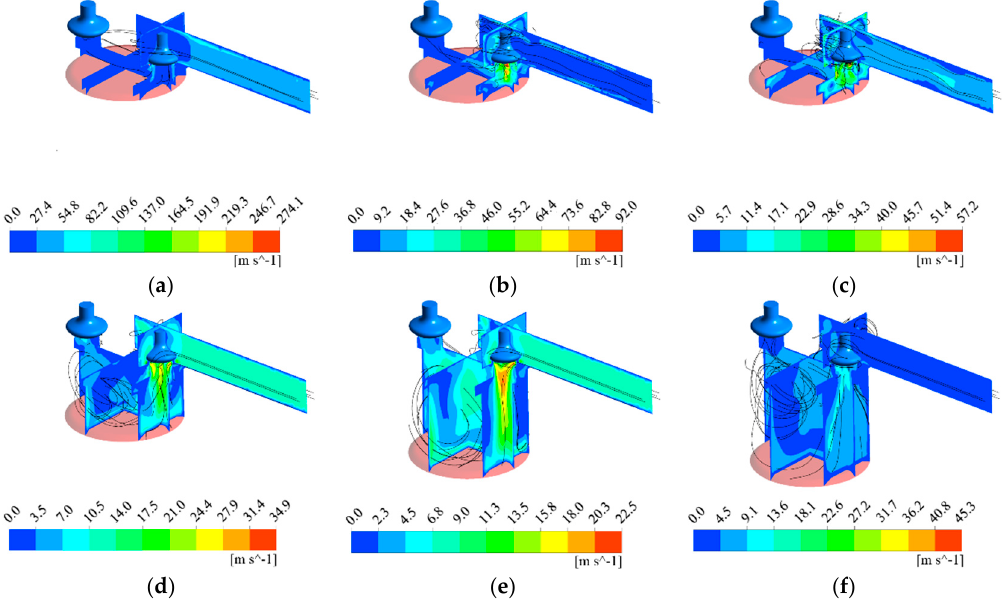
Figure 8. Velocity distribution and streamlines during the intake process: ( a ) θ = 2°; ( b ) θ = 10°; ( c ) θ = 14°; ( d ) θ = 45°; ( e ) θ = 75°; ( f ) θ = 88°.